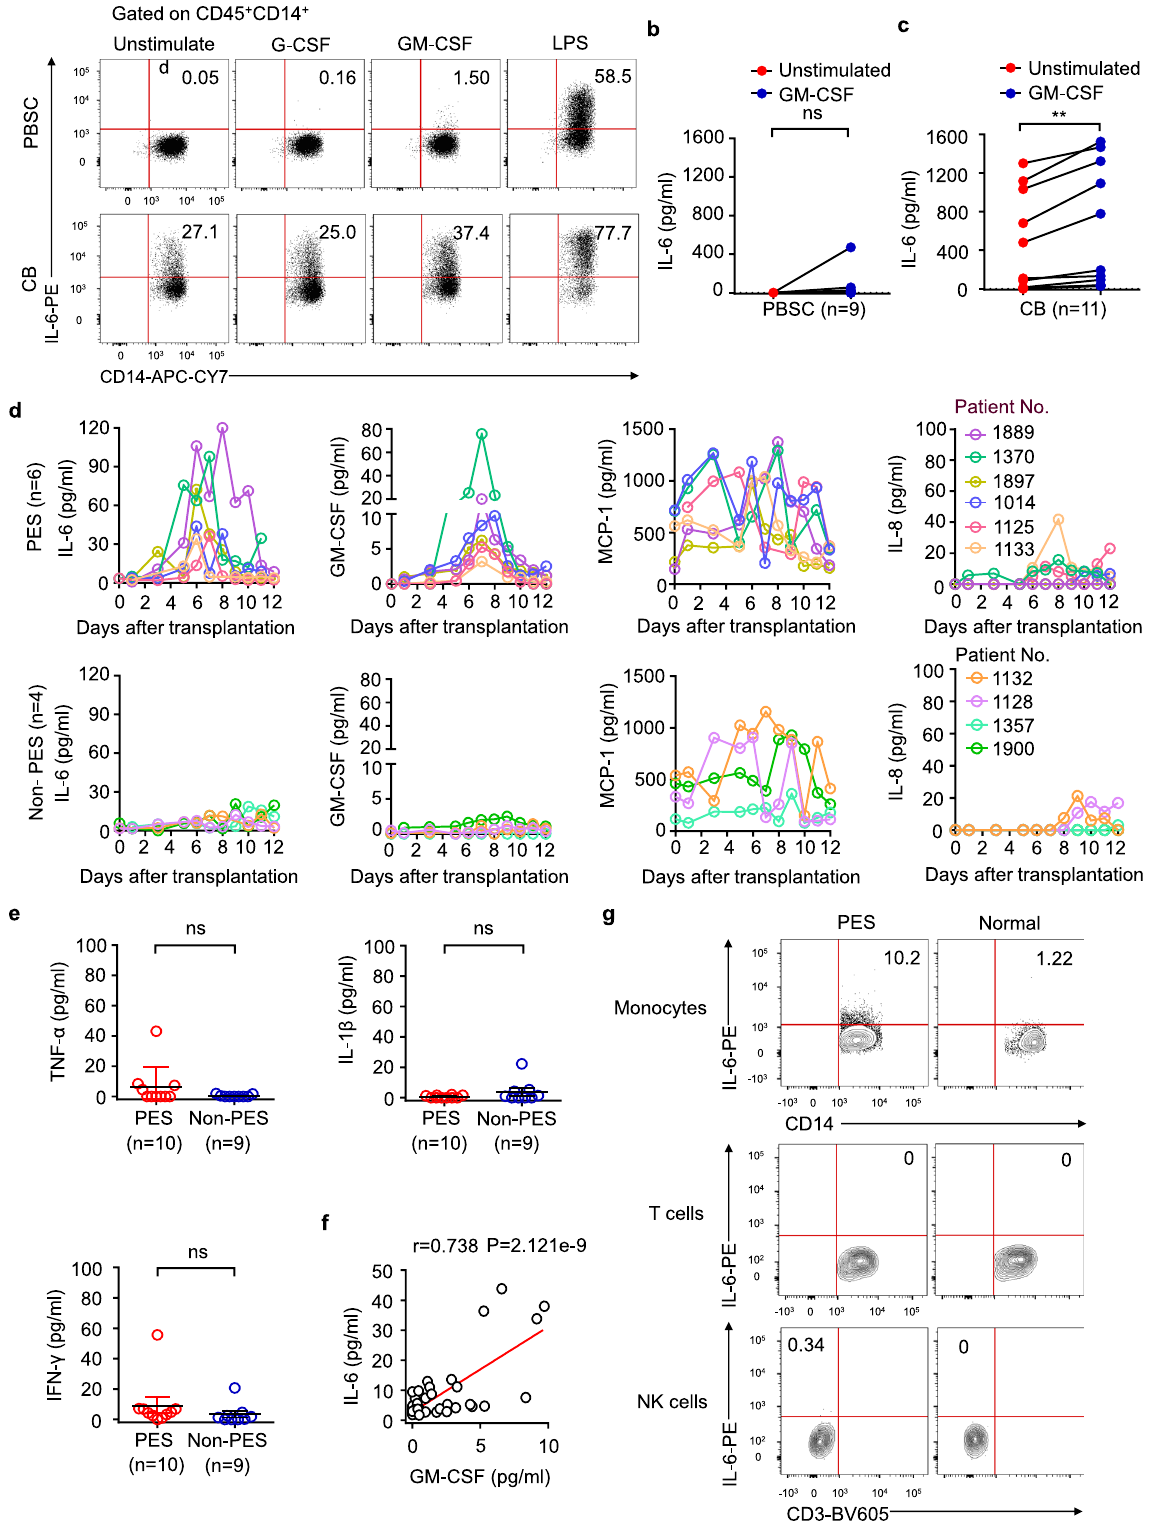
Subjects . Study participants were recruited at the First Af fi liated Hospital of the University of Science and Technology of China. Eligible patients with severe pre-engraftment syndrome, who are steroid-refractory and had a fever in excess of 38.3 °C for three consecutive days, had to be considered fi t in order to receive tocilizumab (Tocilizumab Actemra, Roche). All patients underwent modi fi ed myeloablative conditioning chemotherapy or chemoradiotherapy. Patients or